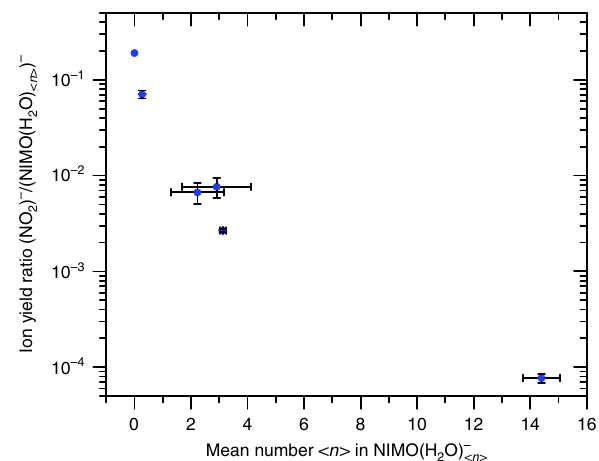
Fig. 3 Closing of the most intense DEA channel with hydration — total ion intensity. The relative intensity of DEA to AA (blue data points) is expressed as the ratio of total yields of NO 2 − to NIMO(H 2 O) n − parent ions at different hydration conditions (see Supplementary Fig. 4). The level of hydration is characterised by the mean number <n> of water molecules attached to the parent anion in NIMO(H 2 O) n − clusters. The number <n> is lower, but directly proportional to the number of water molecules in the neutral precursor cluster (see ref. 24 for details). The statistical uncertainty described by the standard deviation is shown as error bars, see data analysis section for more details. Source data are provided as a